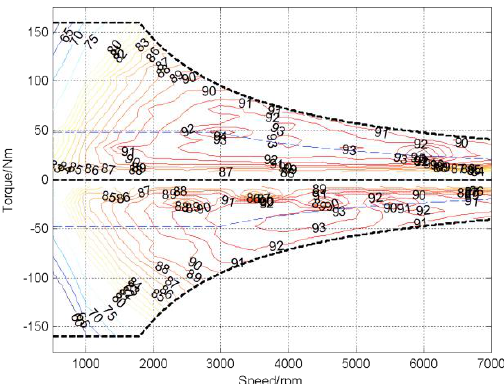
Processes 2022 , 10 , x FOR PEER REVIEW